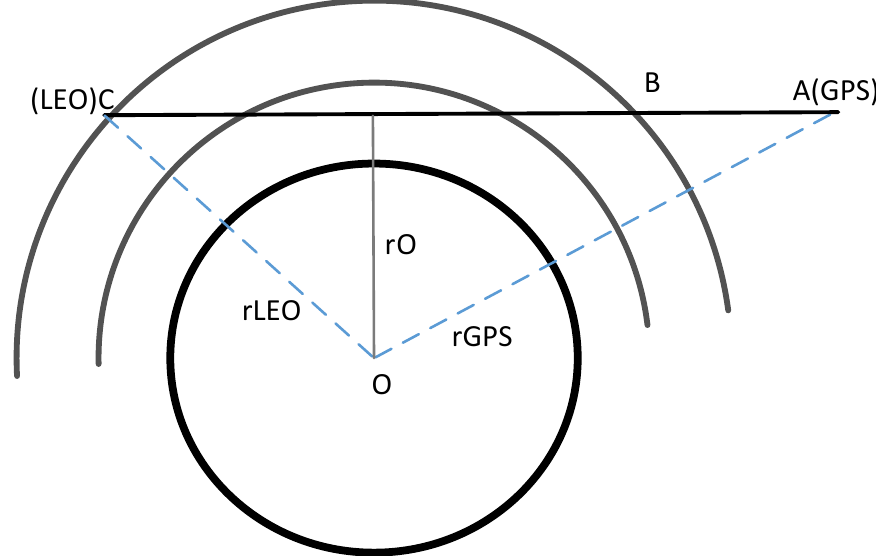
Figure 4. Calculation of the calibrated